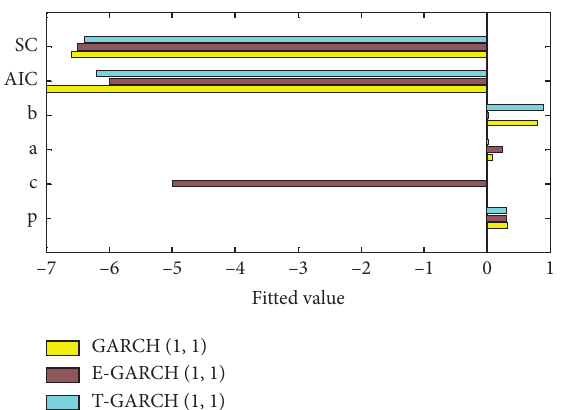
Figure 7: GARCH fitting parameter diagram of palm oil price change series.